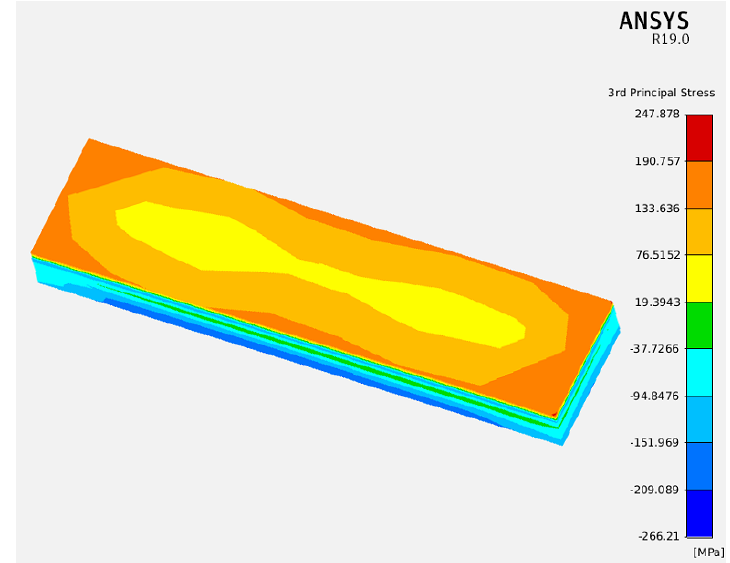
Figure 4. The residual stresses on the surfaces of a quarter of the 6061 aluminium alloy plate after the quenching process numerical